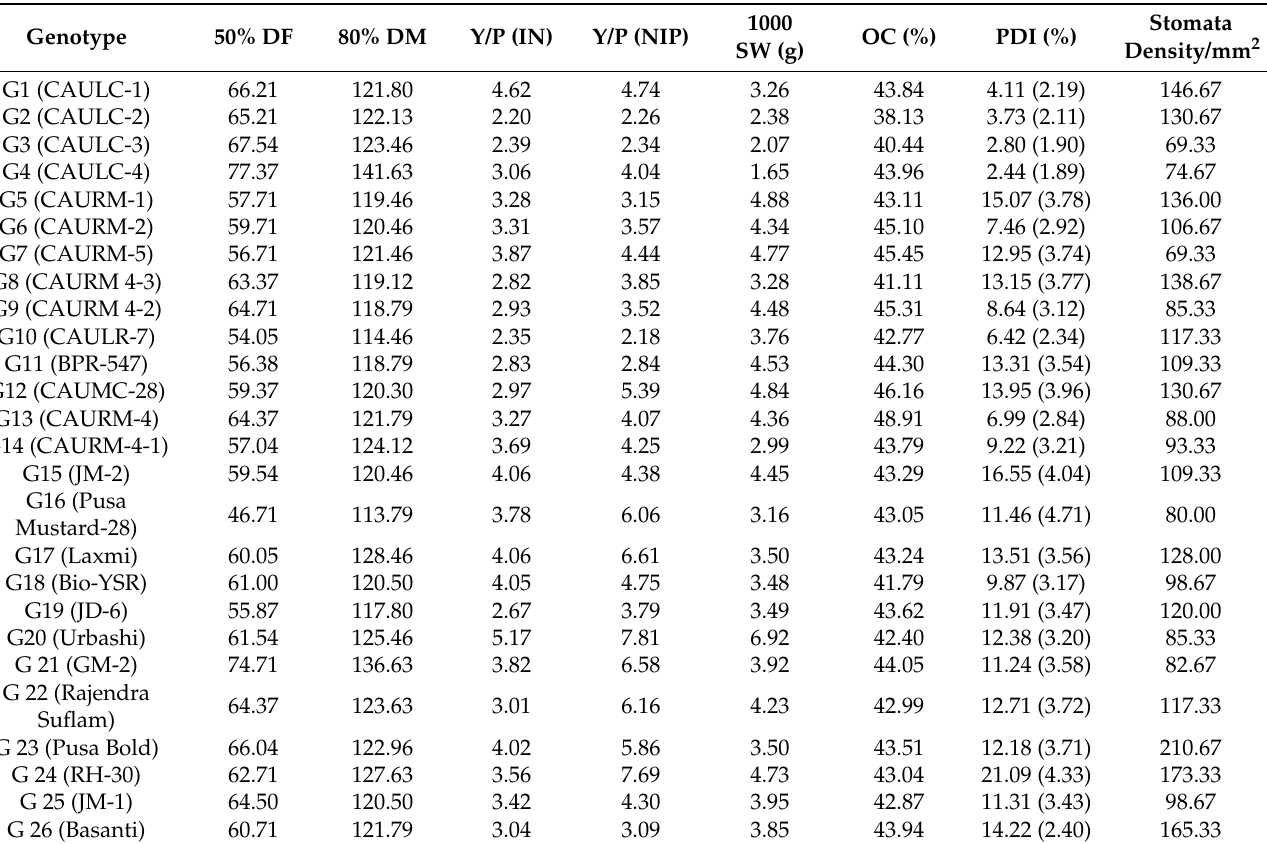
Figure 2. Deformed plant parts due to A. candida infection. Table 3. Mean performance and genetic parameters of 30 Indian mustard genotypes for various agronomic traits.